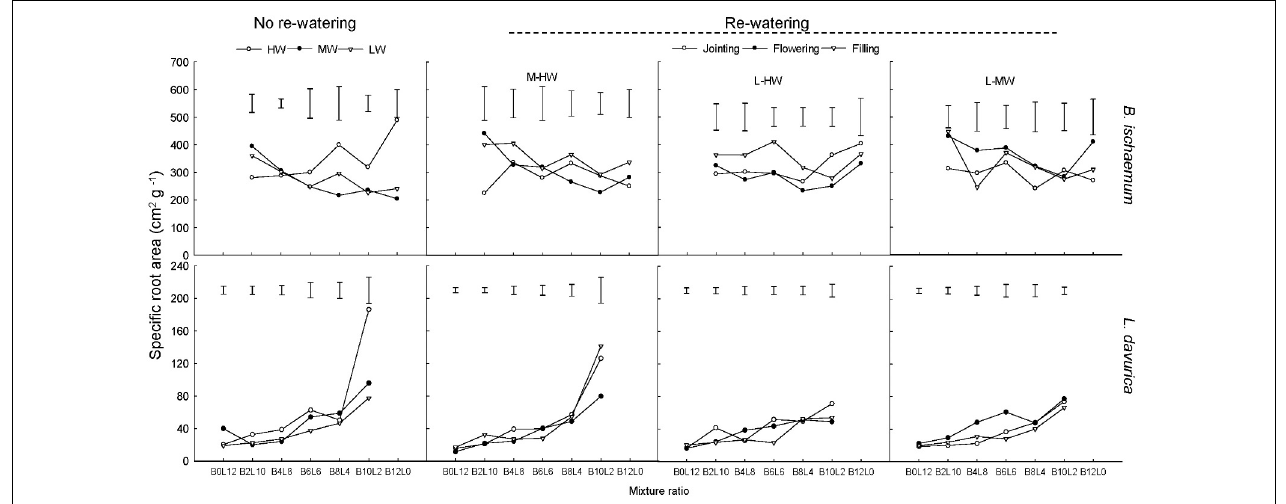
FIGURE 6 | Specific root area (SRA) of B. ischaemum (B) and L. davurica (L) at various mixture ratios under each water treatment. HW: 80 ± 5% FC; MW: 60 ± 5% FC; LW: 40 ± 5% FC; M-HW: soil water content increased from MW to HW; L-MW: soil water content increased from LW to MW; L-HW: soil water content increased from LW to HW. The vertical bars indicate the LSD values ( P ≤ 0.05) for the SRA difference of each species among water treatments at each mixture